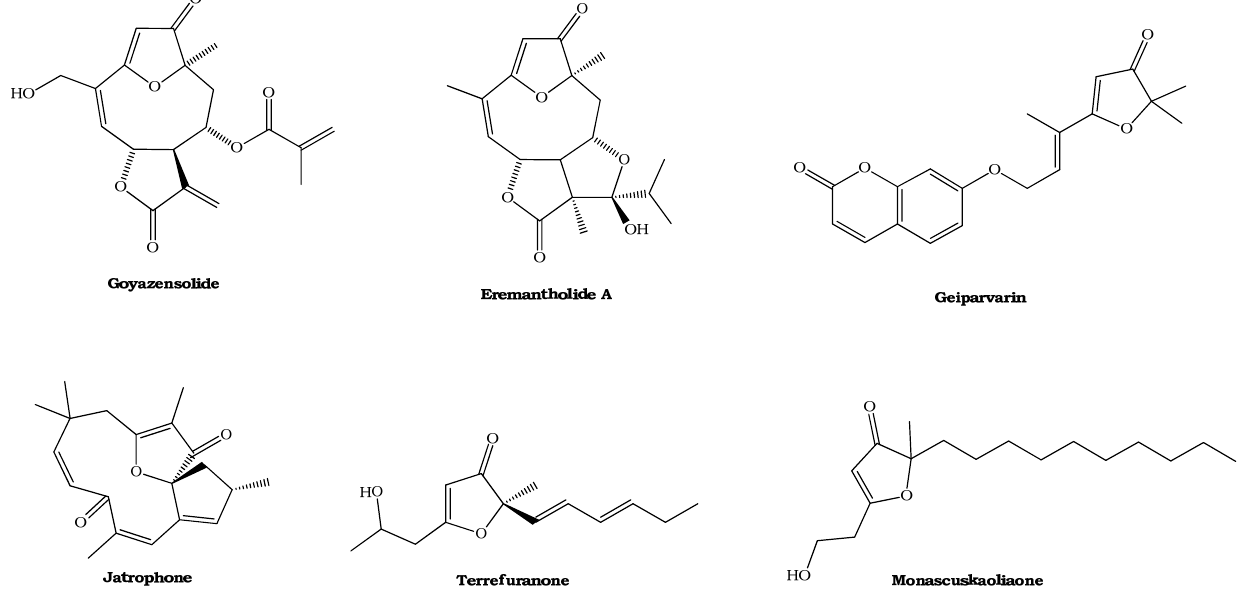
Figure 1. Examples of natural products containing the 3(2 H )-furanone